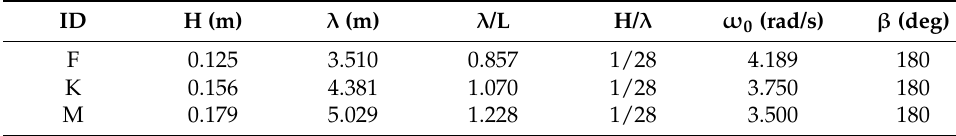
Table 4. The simulation conditions for case F, K and